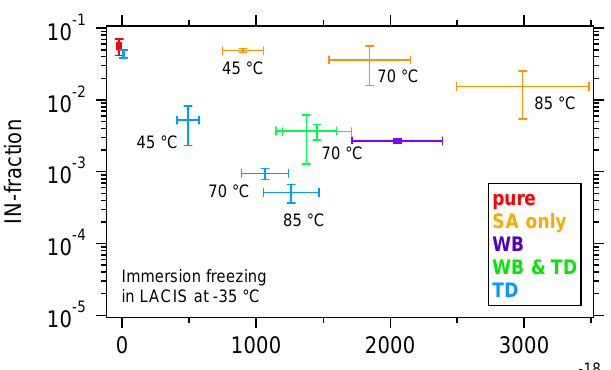
Fig. 11. Comparison of AMS sulphate per particle masses to the LACIS ice nucleus counts at − 35 ◦ C during FROST2. Different sulphuric acid bath temperatures are shown for every particle class. The particle class pure includes those experiments with no treatment and no sulphuric acid condensation. The particles class “SA only” includes particles which passed the sulphuric acid bath but no fur- ther processing was performed. WB indicates the use of the water bath and TD the use of the thermodenuder after the treatment except for the blue point on the upper left which passed the thermodenuder but was not